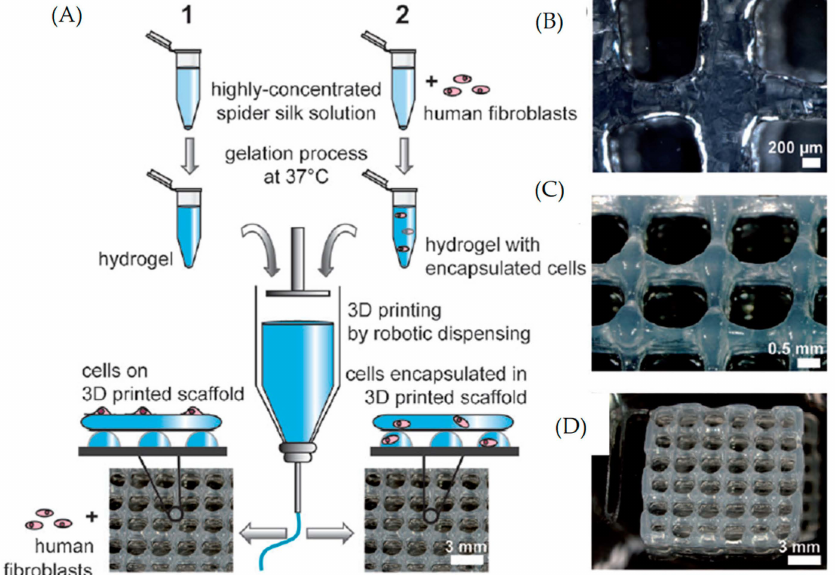
Figure 8. Assessment of the potential of recombinant spider silk protein as a bio-ink for 3D bioprinting by robotic dispensing: ( A ) 3D printing schematic. Cells are either seeded on the scaffold (1) or encapsulated during the printing process (2). ( B ) Stereo-microscopy and digital images of two-layer scaffold(C16) and ( C , D ) eight-layer silk protein bioprinted scaffolds (reprinted from Schacht et al., 2015 [299], with the permission of John Wiley & Sons Inc., published under license. Copyright © 2022 WILEY-VCH Verlag GmbH & Co. KGaA).